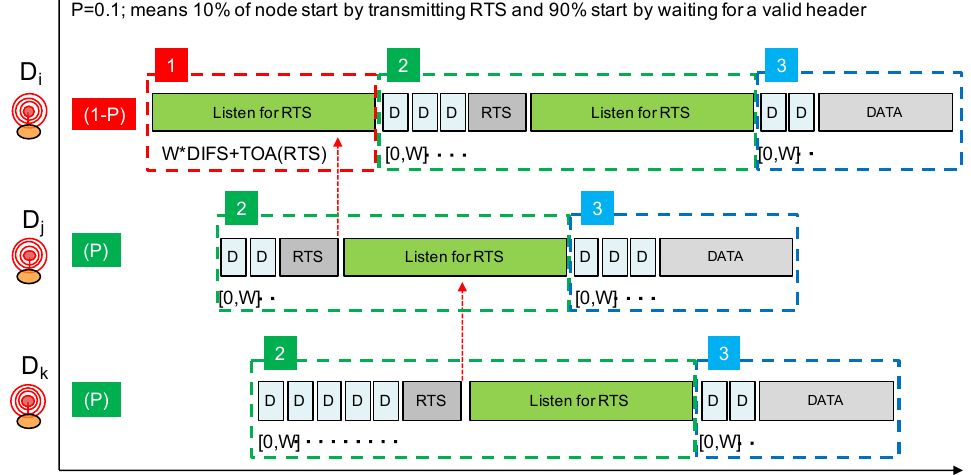
Figure 13. Principle of a channel access mechanism without CCA for LoRa. The proposed channel access approach operates in three phases and a node willing to transmit a data packet will go through these phases in a sequential manner. Phase 1 consists of only a listening period in order to listen for RTS packets. Phase 2 consists of sending the RTS packet immediately followed by another listening period. Prior to the RTS transmission, a random backoff timer is applied. In phase 3, the data packet is transmitted. Again, prior to the data packet transmission, a random backoff timer is applied. The random backoff timer is expressed in number of DIFS whose value is set to the duration of the LoRa packet’s preamble. DIFS therefore depends on the LoRa data rate in order to adapt the various timer according to the time-on-air of packet transmission.